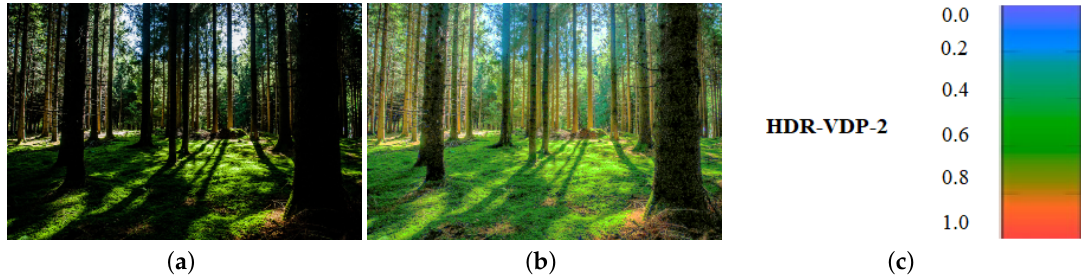
Figure 13. ( a ) An input LDR test image [37]. ( b ) The reference image to predict the visibility difference ( c ) The color scales of the HDR-VDP-2 to show the VDP map.